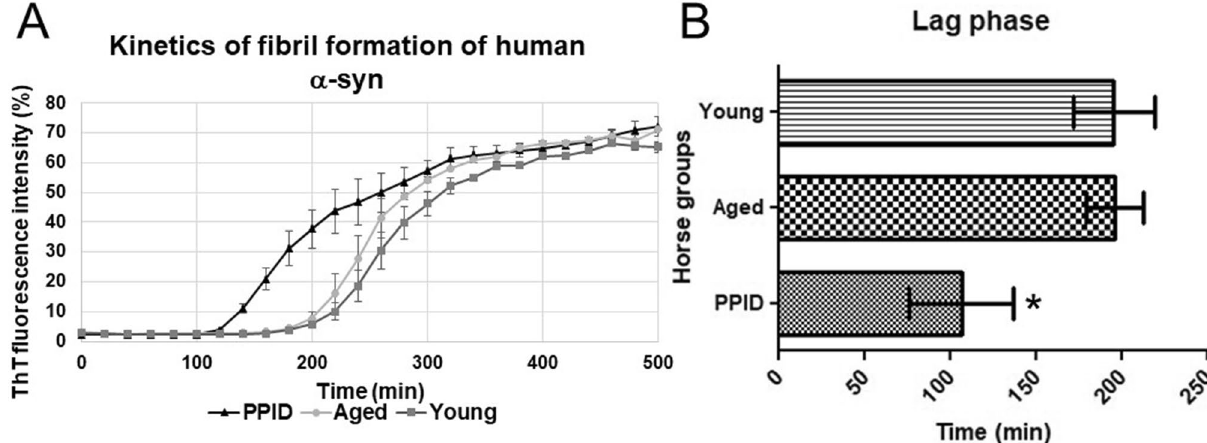
Figure 1. Alpha-synuclein (α-syn) extracted from the pars intermedia of PPID-affected horses has the potential to cross seed recombinant human α-syn. ( A ) Thioflavin T (ThT) fluorescence assay kinetics of human α-syn fibril formation in the presence of equine α-syn isolated from young, aged, and PPID-affected horses. Data represent the mean of the fluorescence intensity with error bars for SEM obtained from three different horses in each group (young, aged, PPID). ( B ) Lag phase time (min) for initiation of human α-syn fibril formation during incubation with equine α-syn extracted from pars intermedia tissue collected from young, aged and PPID-affected horses. The time (min) required for human α-syn fibril elongation (lag phase) is shorter when induced with equine α-syn extracted from PPID-affected horses. Data represent the mean of the lag phase time (min) obtained from five different horses in each group (young, aged, PPID). Data were analyzed by the one-way analysis of variance with Dunnett’s multiple comparison post-hoc testing between groups. (*significant difference p <